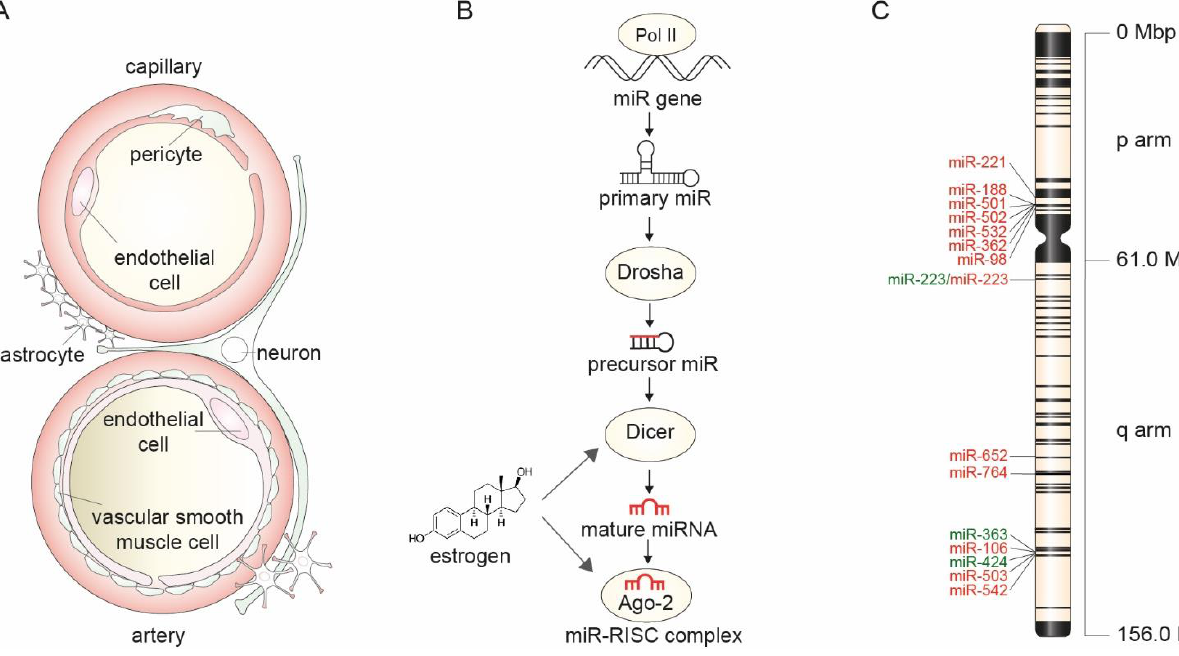
Figure 1. ( A ) The neurovascular unit is a functional unit of neurons, astrocytes, endothelial cells (ECs) and vascular smooth muscle cells (VSMCs) that controls neurovascular coupling, and thereby cerebral blood flow (CBF). ( B ) Estrogen can affect miR transcription and action by controlling the expression of the pre-miR processing protein Dicer, and by increasing Argonaute-2 protein (crucial for miR target recognition and thereby its function) respectively. ( C ) X-chromosome and X-linked miRs involved in the cellular response to injury of neurons, astrocytes, ECs and VSMCs. Red font depicts stroke promoting miRs while green font indicates stroke preventing miRs.